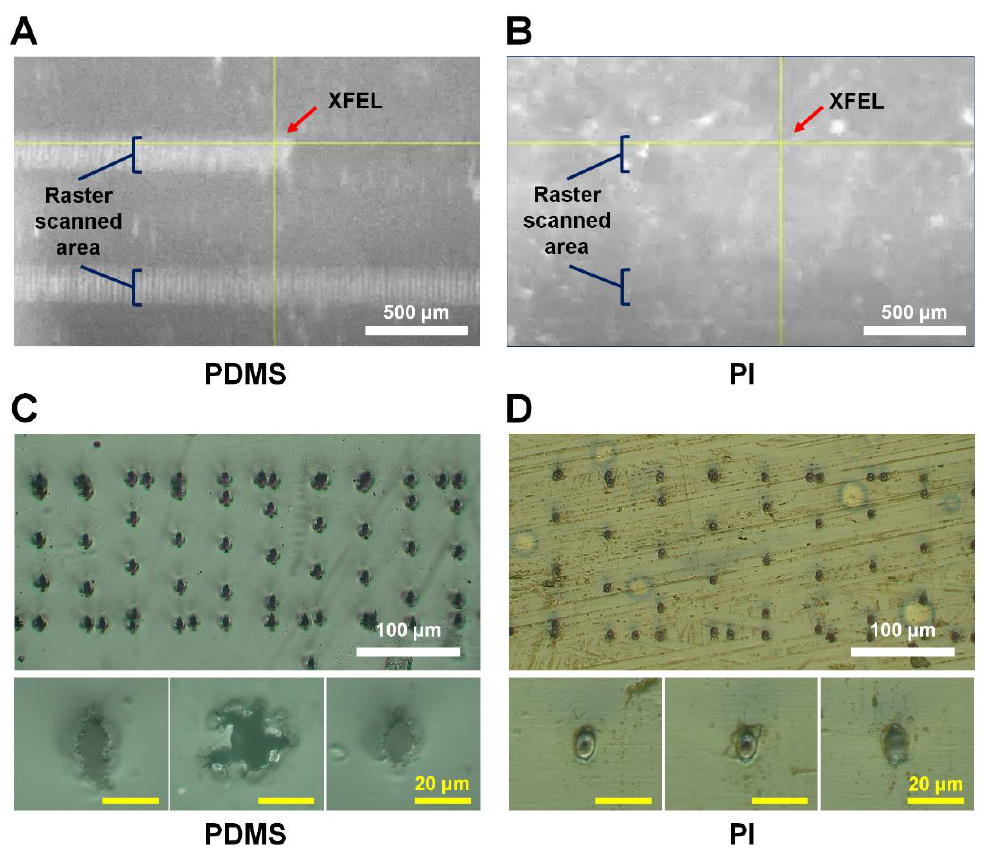
Figure 2. Radiation damage of PDMS and PI by XFEL. Snapshot of the raster scanning of ( A ) PDMS and ( B ) PI during XFEL exposure. During raster scanning, with exposure to XFEL, the film was moved, stepping twice by 50 µ m in the vertical, then once by 50 µ m in the horizontal. High-resolution microscopic view of XFEL-induced radiation damaged ( C ) PDMS and ( D ) PI.